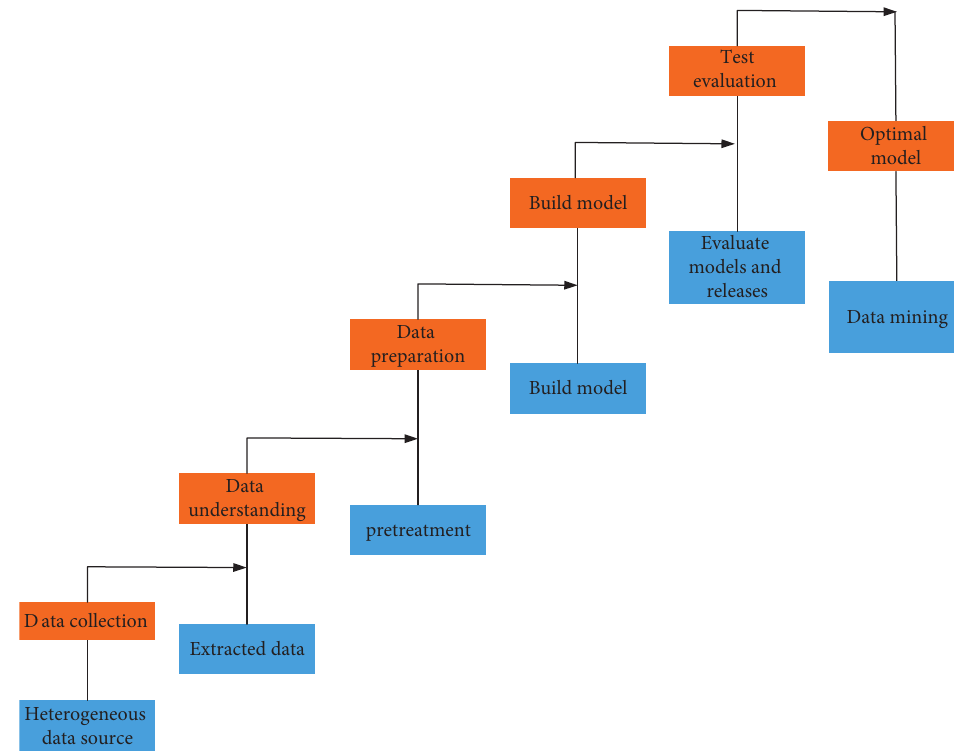
Figure 1: Data mining